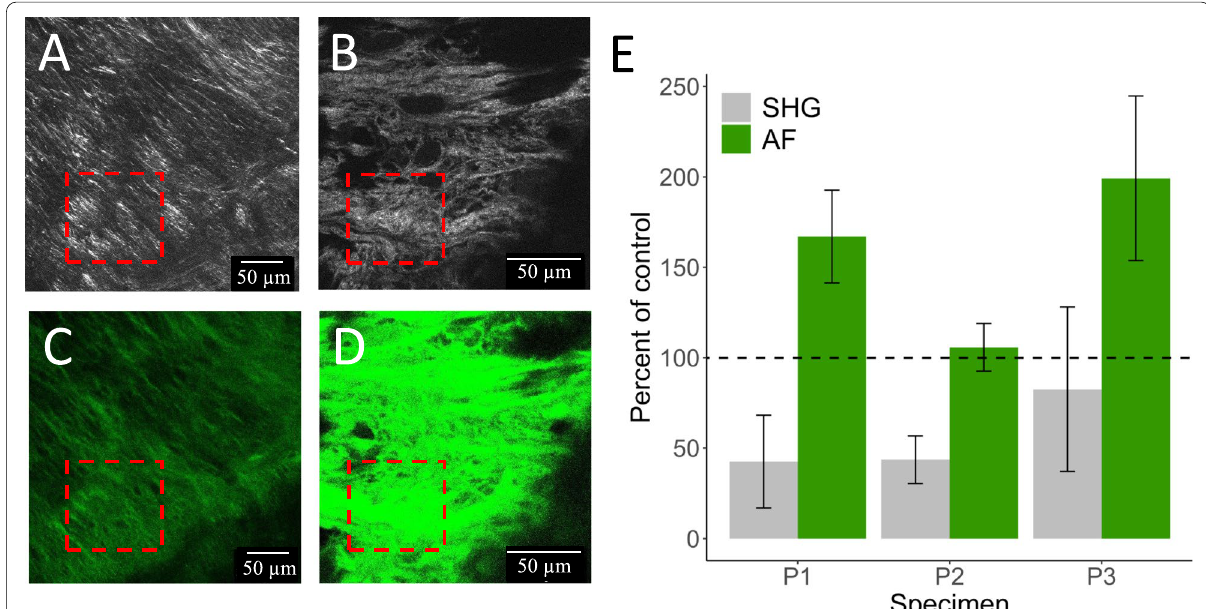
Fig. 2 Representative images of SHG and AF images from specimen P1 using benchtop CMM and compiled paired specimen results. A Control ACL SHG, B Fatigue loaded ACL SHG, C Control ACL AF, D Fatigue loaded ACL AF, E The results of all paired knee samples P1 – P3 reported as the intensity of fatigue loaded ACL as a percentage of contralateral control ACL represented by the dashed line at 100%. All fatigue loaded ACLs displayed a reduced SHG signal intensity compared to their contralateral control, whereas the AF signal intensity was enhanced. Red dashed boxes (100 100 μm 2 ) indicate regions of interest (ROI) used to quantify SHG and AF intensity ×